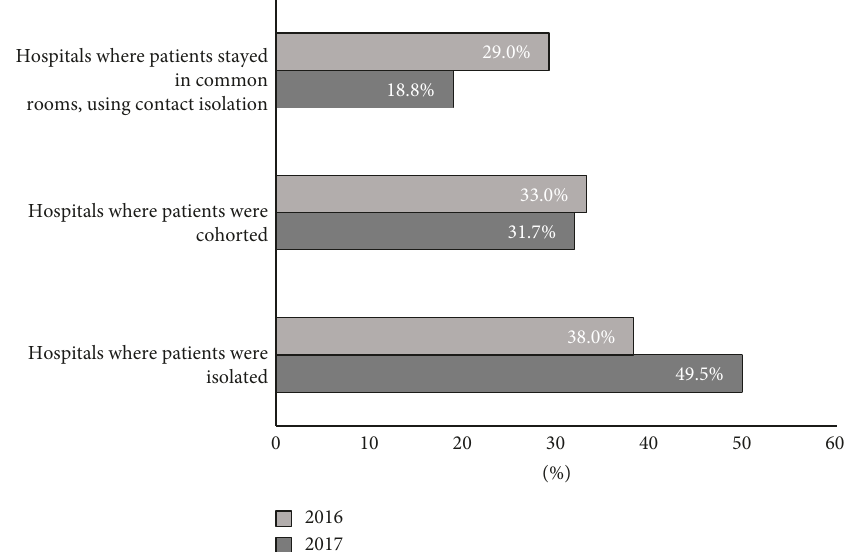
Figure 1: Use of patient isolation as an antiepidemic procedure in hospitals in the Mazovian Voivodeship in 2016–2017. Table 1: Hand disinfection as an antiepidemic procedure in hospitals in the Mazovian Voivodeship in 2016–2017. Procedure